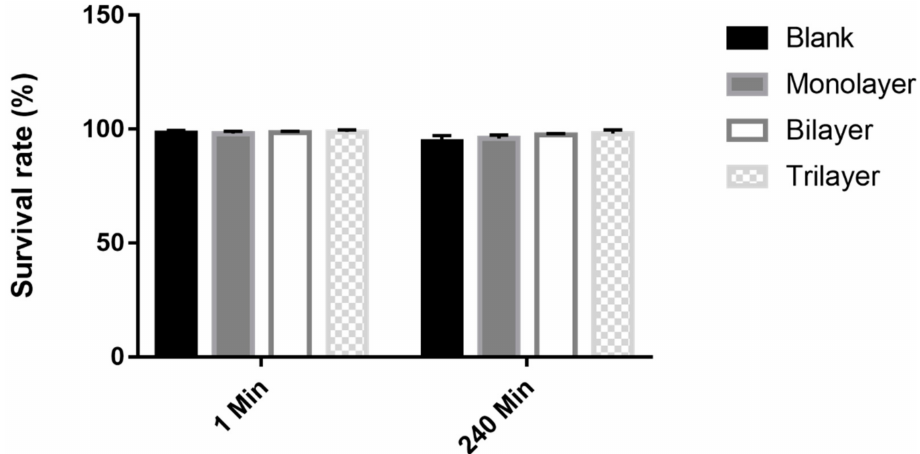
Figure 8. Survival rate of free and encapsulated L. casei K17 under simulated intestinal environment for 240 min. Values (mean ± SE, n =